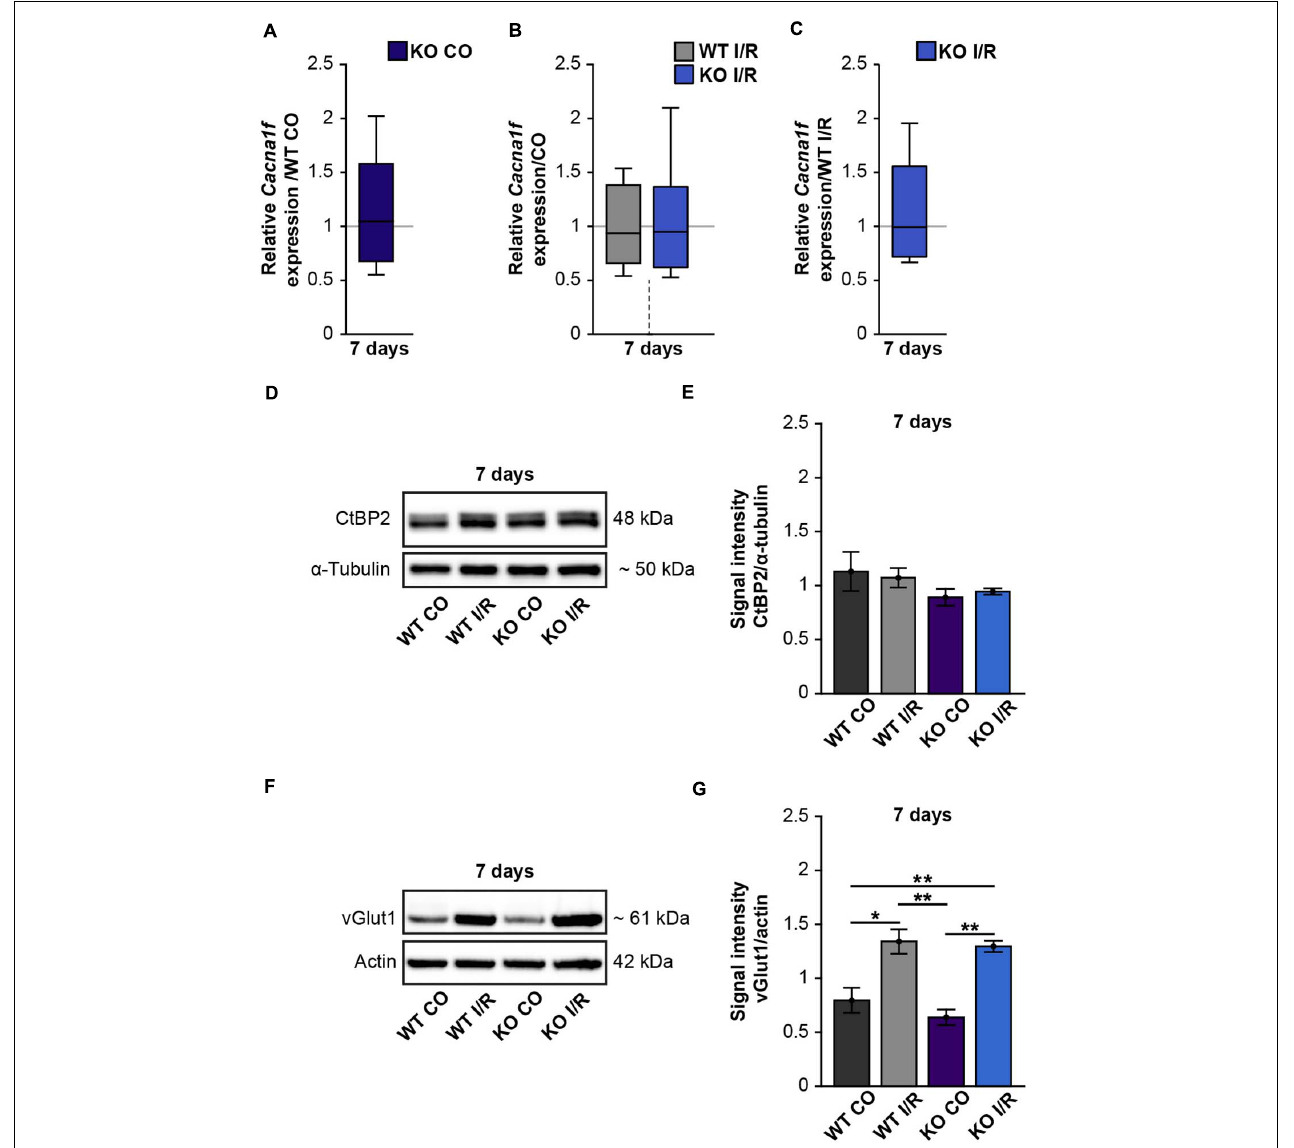
FIGURE 7 | Enhanced protein levels of the pre-synaptic marker vGlut1 after retinal ischemia. (A–C) RT-qPCR analyses of the synaptic marker Cacna1f at 7 days after ischemia. (A) Equivalent mRNA expression levels were observed for Cacnaf1 in the KO CO compared to the WT CO group. (B) Similar levels of Cacnaf1 were measured in the WT I/R compared to the WT CO group as well as in the KO I/R compared to the KO CO group. (C) Cacnaf1 mRNA expression levels were also found to be comparable in both ischemic groups. (D) Representative Western blots of CtBP2/ribeye at 7 days post-I/R. (E) Quantification of the band intensity revealed similar CtBP2 protein levels in the retina of all groups. (F) Exemplary Western blots of vGlut1 at 7 days post-I/R. (G) Quantification of the band intensity showed significantly elevated vGlut1 protein levels in the retina of both ischemic groups. For Western blot analyses, groups were analyzed using two-way ANOVA followed by Tukey’s post hoc test. These data are displayed as mean ± SEM in panels (E,G) . For RT-qPCR analyses, groups were analyzed using the pairwise fixed reallocation and randomization test and data in panels (A–C) are shown as median ± quartile ± minimum/maximum. * p < 0.05; ** p < 0.01. n =